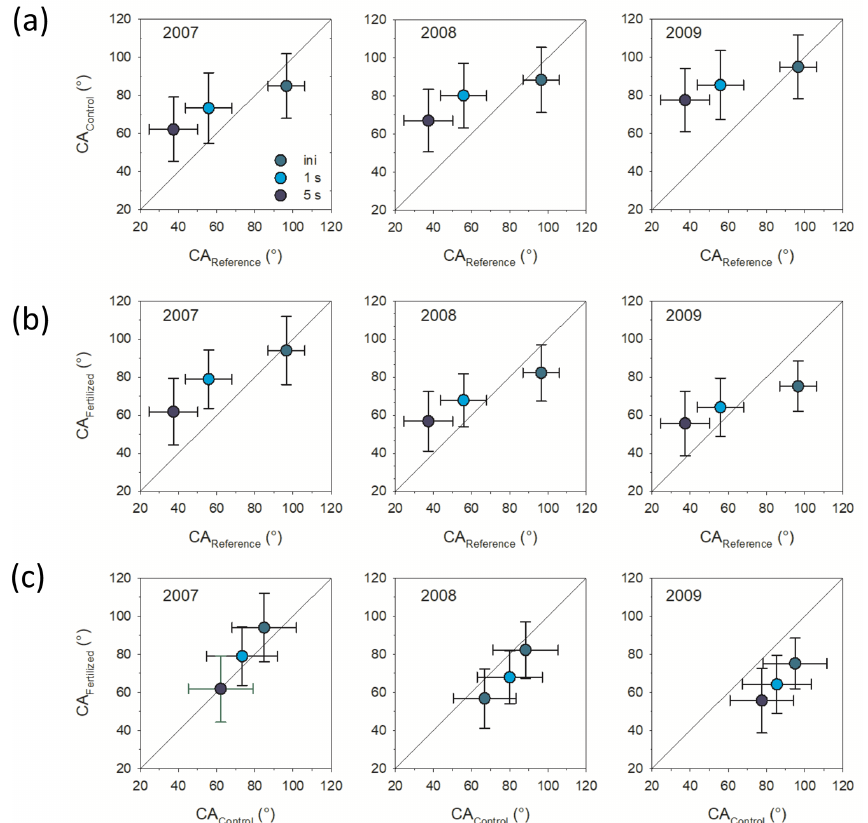
Figure 1. Contact angle (CA) comparisons between (a) control treatment and reference material, (b) fertilization treatment and reference material, and (c) control and fertilized treatments. Shown is the initial CA (ini), determined directly after placement of the water drop and CA determined 1 and 5s after placement of the water drop. Bars represent standard deviation ( n =